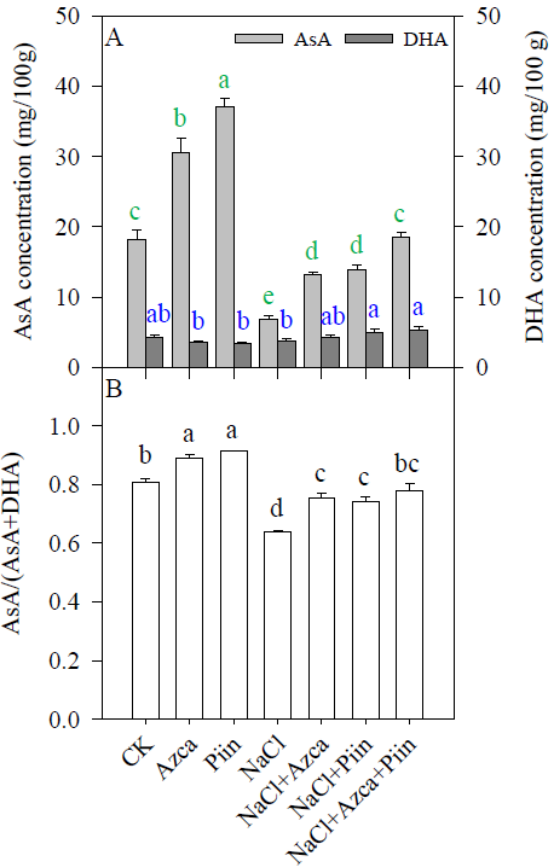
Figure 7. Changes in AsA and DHA concentrations and the ratios of AsA/(AsA + DHA) in leaves of tomato plants under different treatments. ( A ): AsA and DHA concentrations; and ( B ): the ratios of AsA/(AsA + DHA). Results were shown as mean ± SE ( n = 3). Green and blue lowercases indicate statistical differences of AsA and DHA concentrations, respectively. The means with the same lowercases indicate that the differences were insignificant ( p > 0.05).